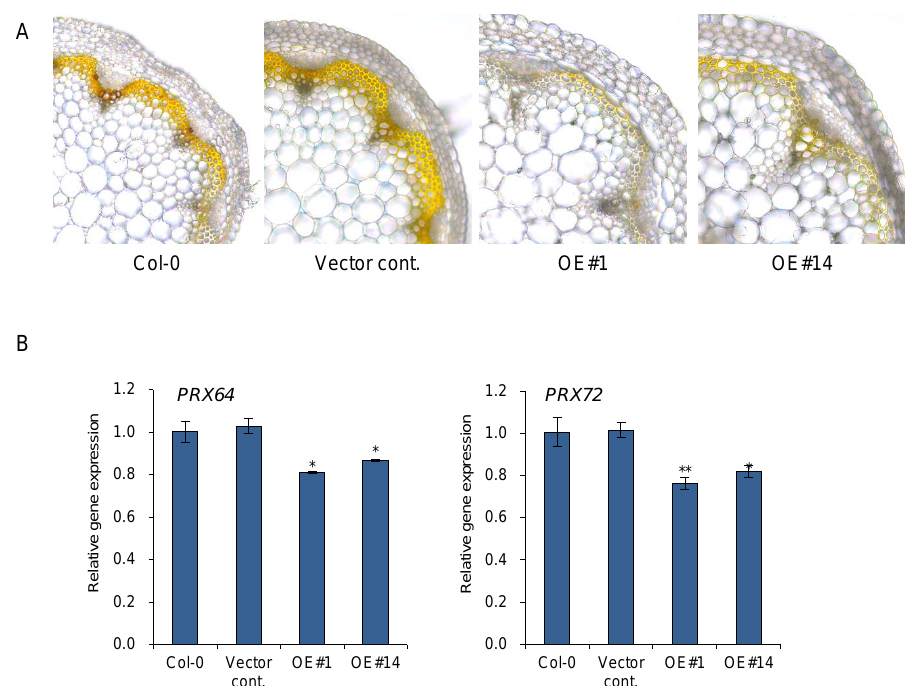
Figure 5. Accumulation of hydrogen peroxide was reduced in pPLAIII γ OE lines. ( A ) 3,3 (cid:48) - diaminobenzidine (DAB) staining and ( B ) expression levels of two peroxidases, PRX64 and PRX72 , in 7-week-old stem. Scale bar = 10 µ m. Each data point represents the average ± SE of three independent replicates at p < 0.05 (*) and p < 0.01 (**),